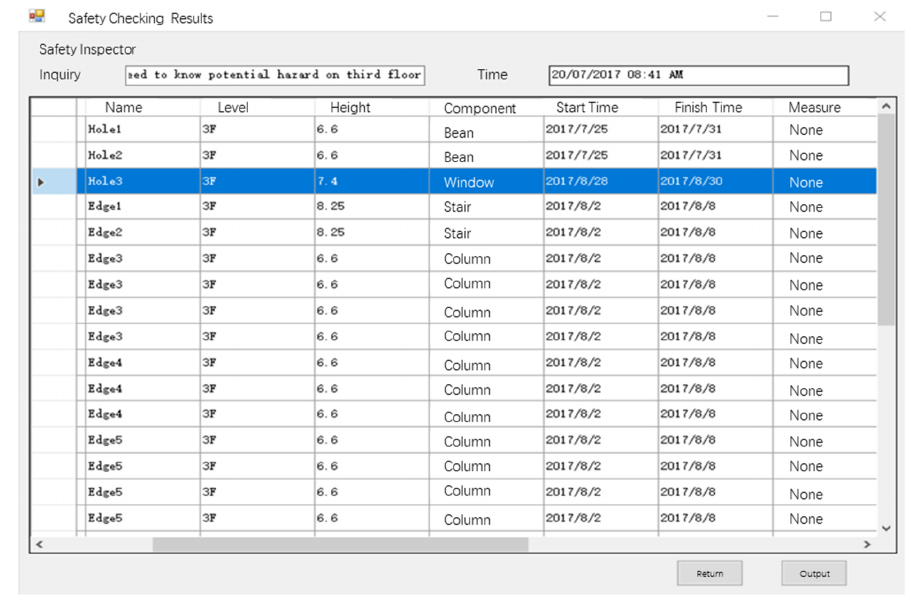
Figure 23. Safety risk query result for potential risks on the third floor.